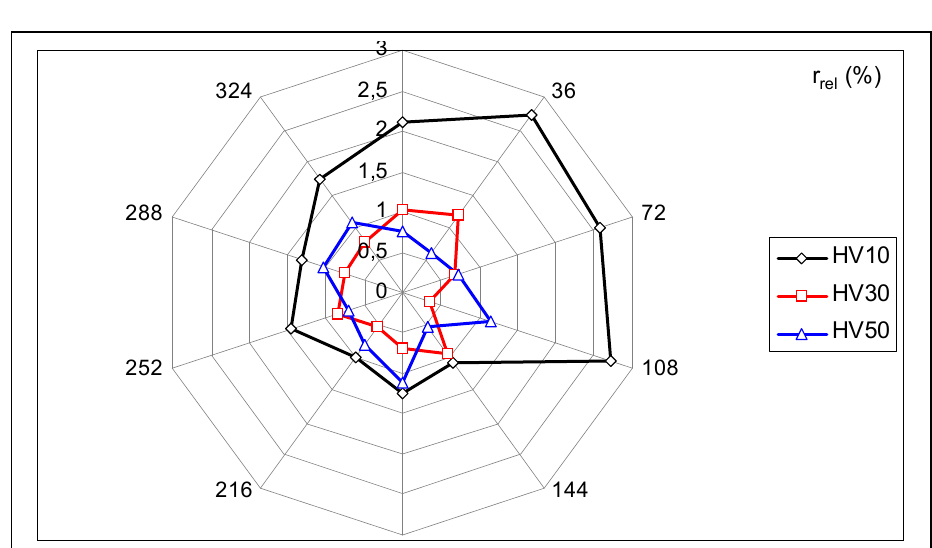
Figure 2 – The influence of the rotation of indenter on the repeatibility r